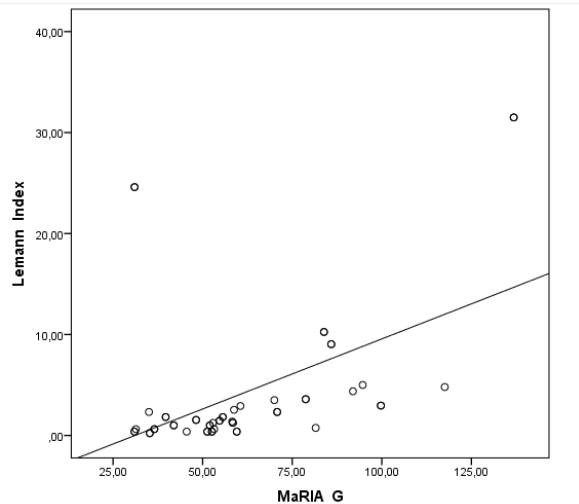
Figure 4: Correlation of Lemann Index and Magnetic Resonance Index of Activity Global.